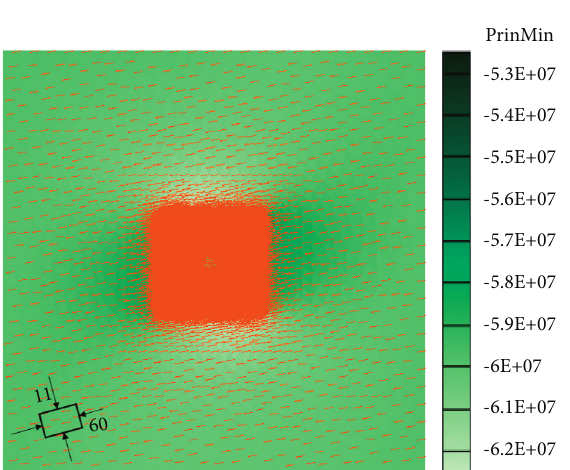
Figure 7: First principal stress after the initial elastic